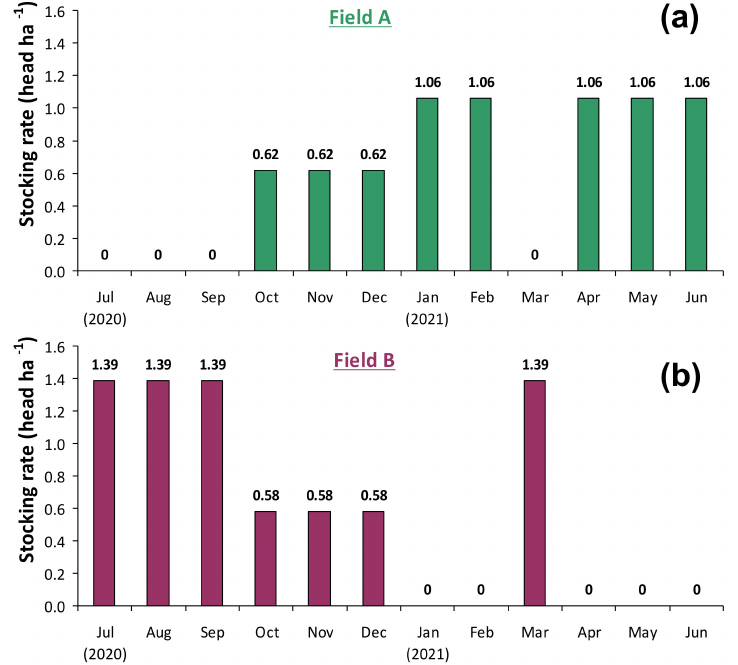
Figure 5. Stocking rates used in the experimental fields “A” ( a ) and “B” ( b ) (July 2020 to June